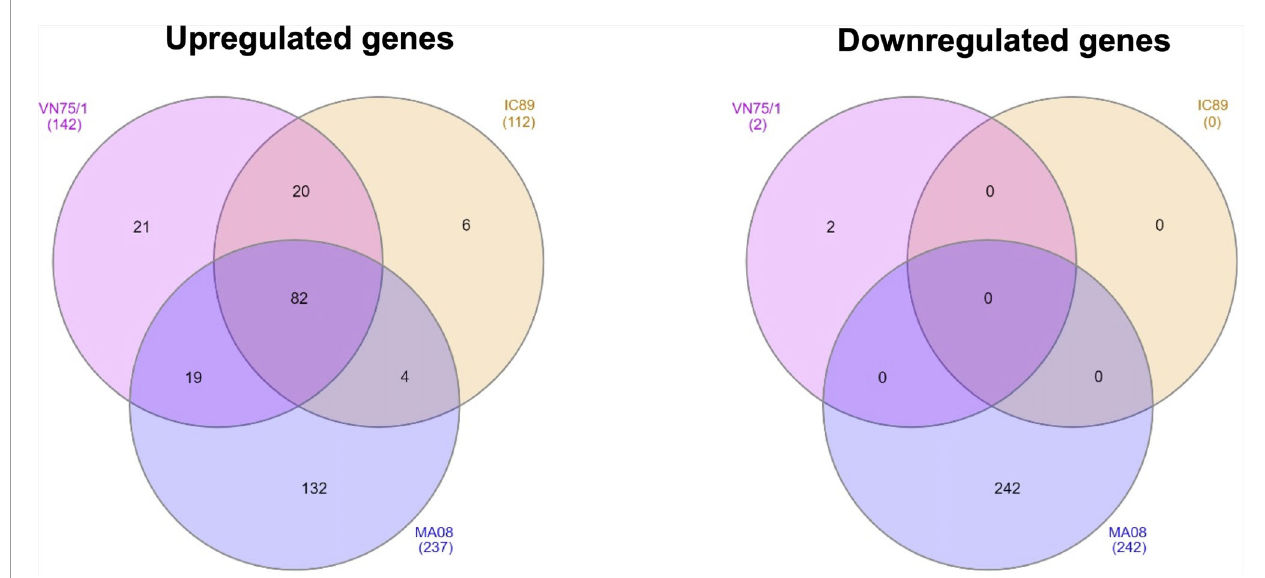
FIGURE 3 | Venn diagrams of up- and down-regulated genes between PPRV infections determined using DESeq2. Venn diagrams were obtained using InteractiVenn. The gene lists were obtained by comparison with DESeq2 of each infection and the mock control (mock-infected cells) at 72 hpi. A threshold of |Log2FoldChange| >1 and an adjusted p-value < 0.05 were